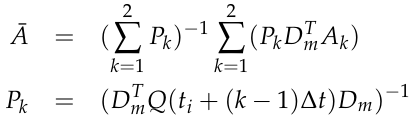
(cid:113) ) /3 ( b ) in the two-epoch case with ∆ t of 30 s. The satellite tr ( Q ˆ b ˆ b